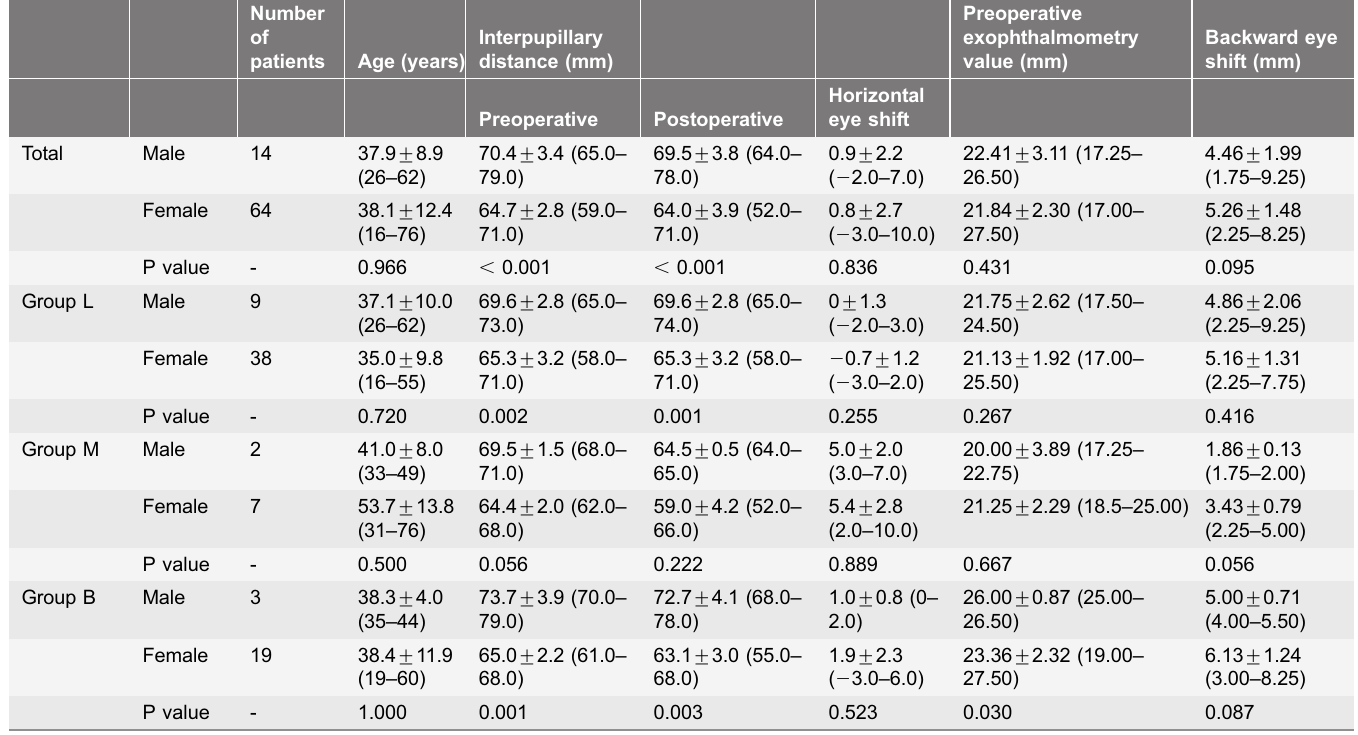
Table 3. Gender-specific measurement results and statistical comparisons in in thyroid eye disease patients.